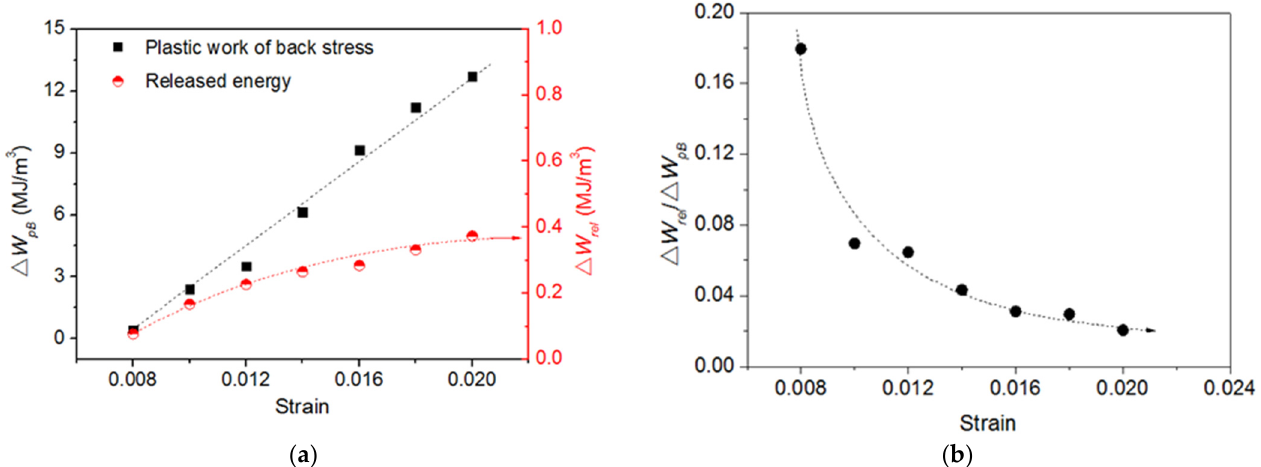
Figure 12. The relationship between ∆ W pB and ∆ W rel : ( a ) the evolution of ∆ W pB and ∆ W rel at half-life versus strain; ( b )the evolution of ∆ W rel / ∆ W pB versus strain.